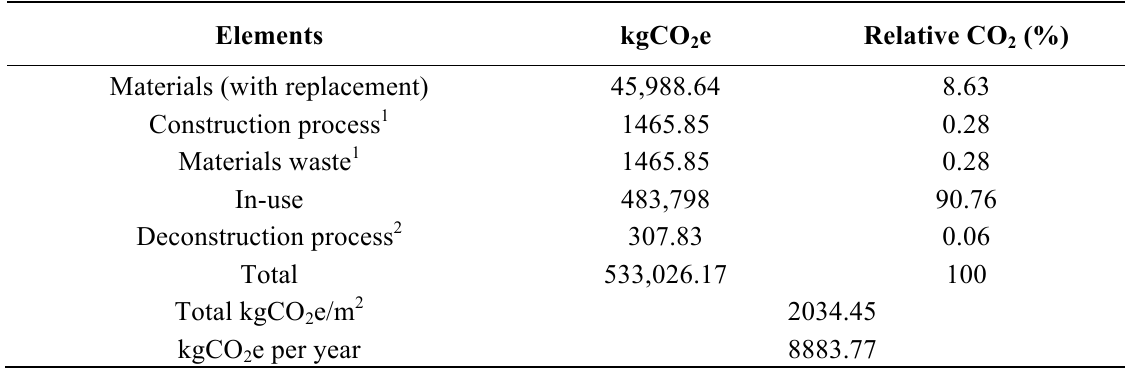
Table 9. Whole life emissions for the refurbished building (all three new housing units) at Cross Street over 60